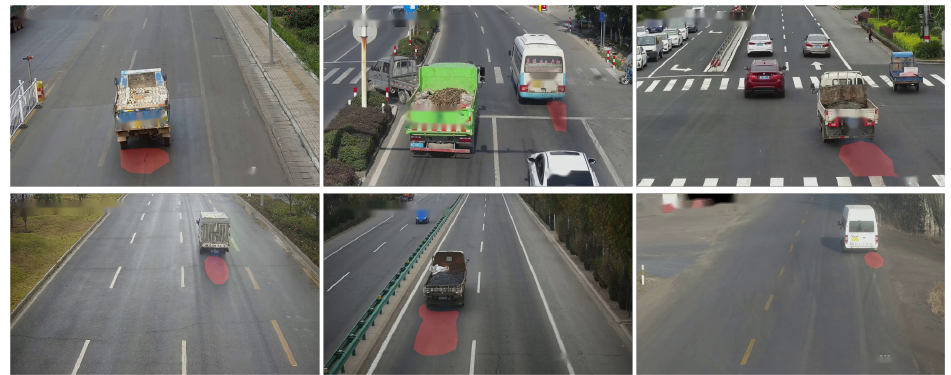
Figure 2. Several samples in the PoVSSeg. The PoVSSeg contained vehicle smoke images from various traffic scenes and annotated with the